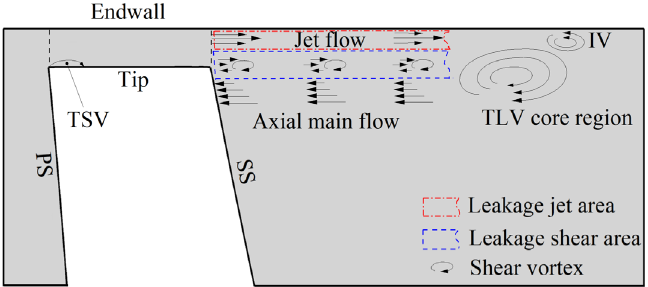
Figure 7. Schematic diagram of axial main flow, tip leakage flow and vortex distribution (λ = 0.5 section).